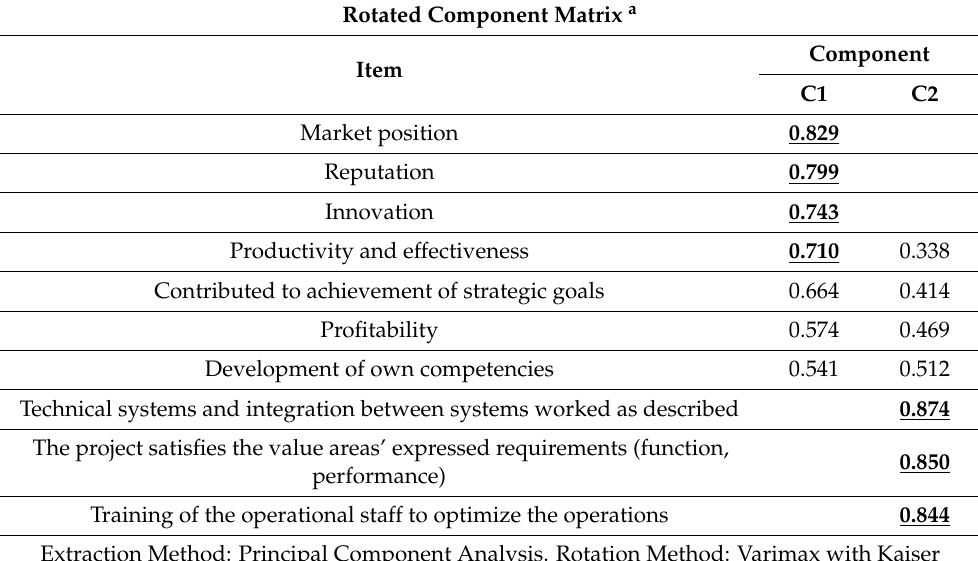
Table 3. Rotated component matrix—experiences with the completed building—positive effects from the